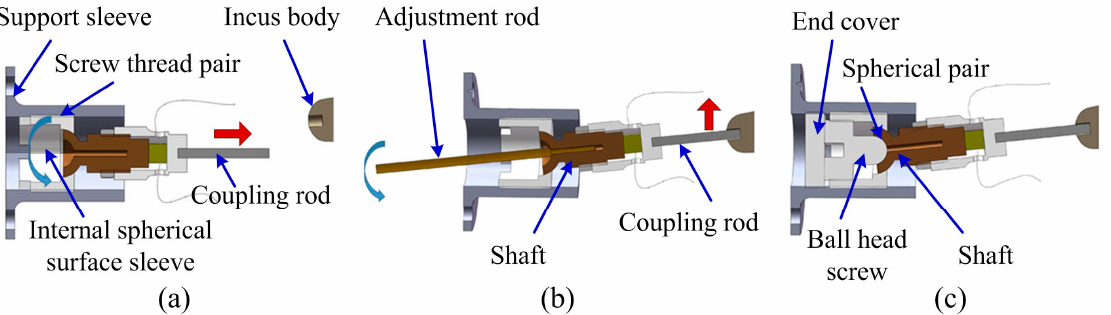
Figure 4. Position adjustments of the coupling rod’s tip. ( a ) Axial adjustment by screwing the internal spherical surface sleeve; ( b ) radial adjustment by rotating the shaft with an adjustment rod; ( c ) fix of the coupling rod by screwing the ball head screw and the end cover.